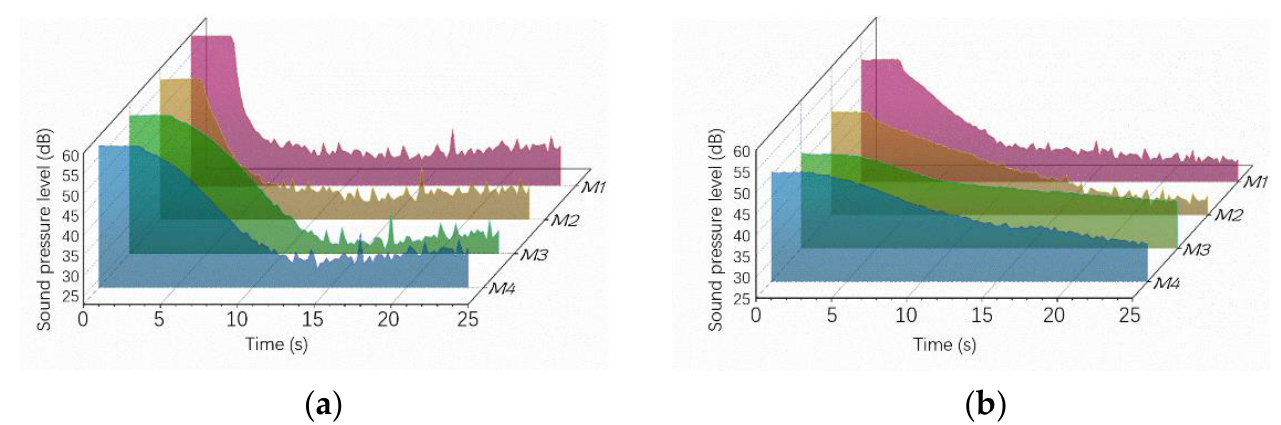
Figure 10. Variation curve of the sound pressure level of the noise: ( a ) 200 Hz single ‐ frequency; ( b ) 150 Hz, 250 Hz, and 400 Hz mixed ‐ frequency.